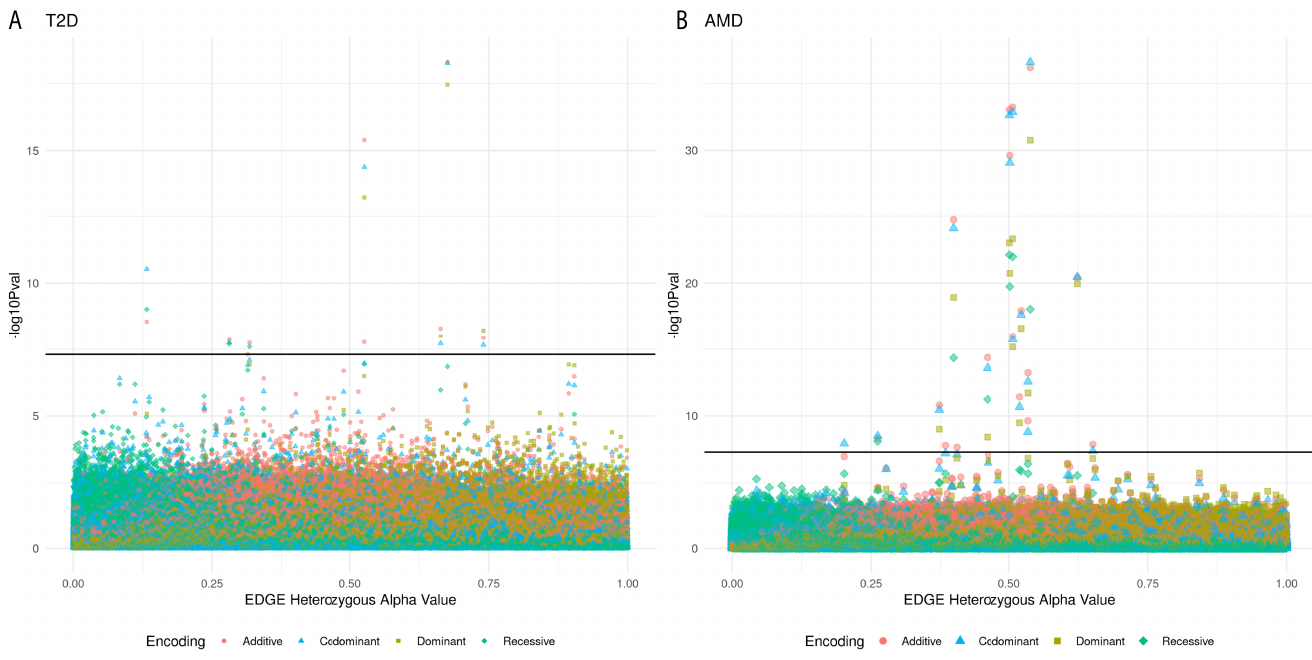
Fig 8. Manhattan plot of results from a multi-encoding GWAS for T2D (A) and AMD (B). GWAS were performed using the additive (red circle), dominant (yellow square), recessive (green diamond) and codominant (blue triangle) encodings for A) 358,569 SNPs and 20,341samples (7,101 cases and 13,240 controls, 53% female) for type 2 diabetes and B) 311,161 SNPs and 13,153 samples (961 cases and 4,129, 56% female) for AMD. SNPs with EDGE-derived alpha values between 0 and 1 were sorted by the alpha value along the x-axis. Along the y-axis is the–log10 of the uncorrected p-value. The black line denotes the genome-wide significance threshold (5 × 10 − 8